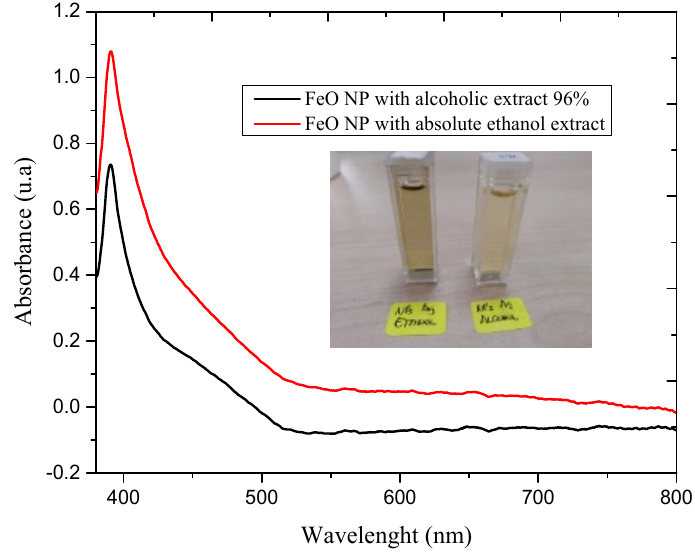
Figure 2. UV-vis spectrum of FeO NP obtained by the green route, using extracts of M. indica in different solvents. The inset shows the colloids FeO NP obtained.